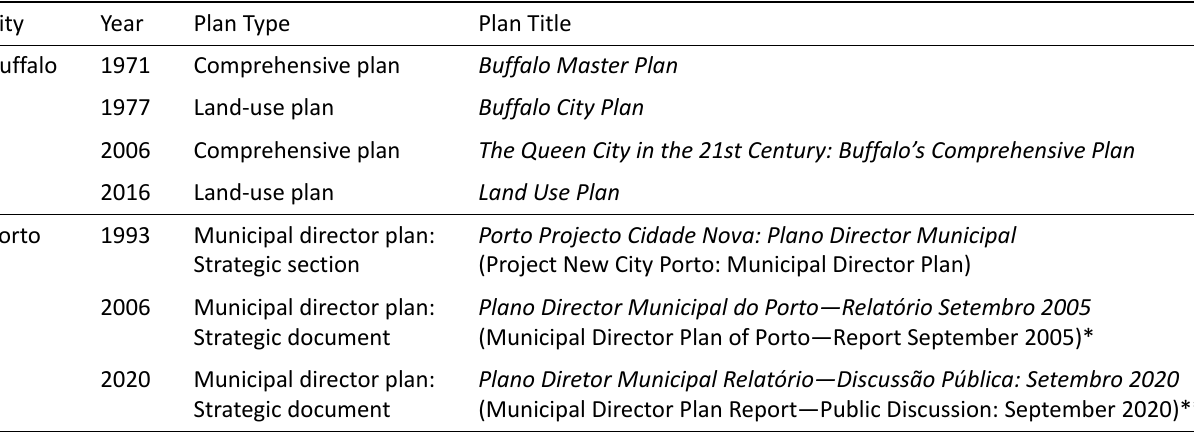
Table 1. Overview of the planning documents